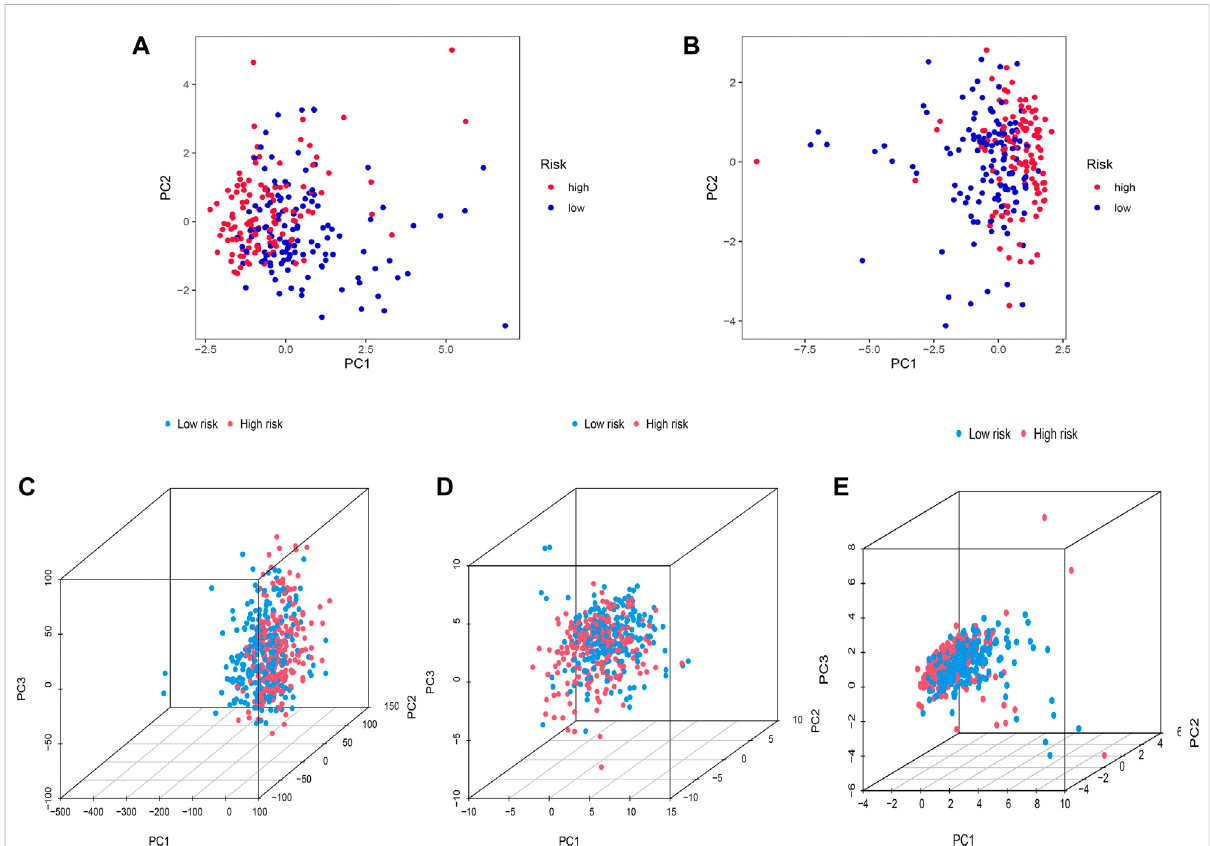
FIGURE 5 Principalcomponentanalysis. (A , B) 2DPCAintrainingandtheentireset. (C – E) PCAbetweentworiskgroupsforentiregeneexpressionpro fi les, 92 FAM related-genes, and pro fi les of the 12 FAM-related lncRNAs as an entire